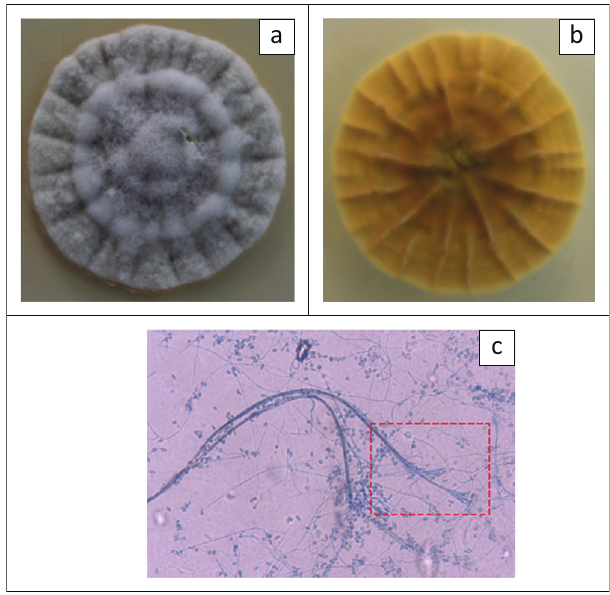
a b FIGURE 1: Dark-grey colonies (a) with pale-yellow reverse (b) of Scedosporium apiospermum macroscopically, grown at 35 °C on Sabouraud Dextrose media with amikacin. Microscopic view of Scedosporium apiospermum stained with lactophenol cotton blue (binocular, light microscope: 200X). The red box (dashed line) area highlights the conidiophores aggregated in the characteristic bundles of tree-like synnemata (c).